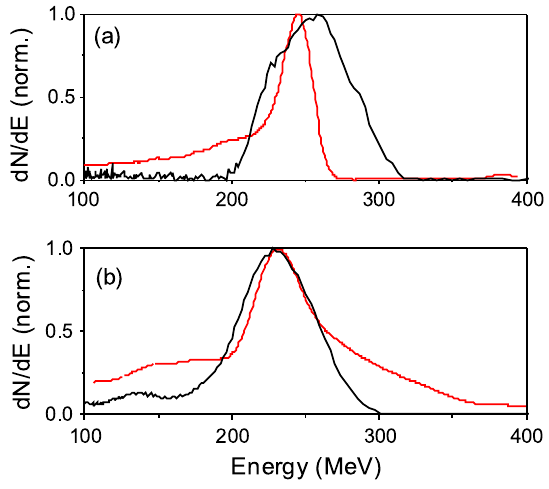
FIG. 10. Lineouts of experimental (black), and simulated (red) electron energy spectra for the parameters (a) of Fig. 4(c) ( P ¼ 43 TW , n e ¼ 7 : 2 (cid:2) 10 18 cm (cid:3) 3 ) and (b) of Fig. 4(d) ( P ¼ 43 TW , n e ¼ 7 : 8 (cid:2) 10 18 cm (cid:3) 3